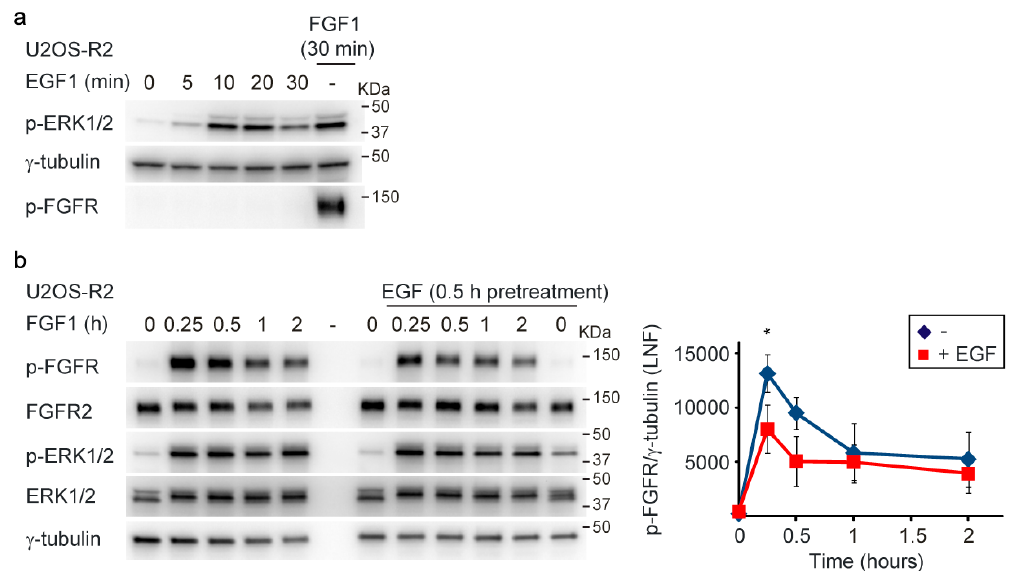
Figure 2. Pretreatment with EGF reduces the response to FGF1. ( a ) U2OS ‐ R2 cells were kept in serum ‐ free media for 2 hours and then 100 ng/mL EGF or 100 ng/mL FGF1 was added to the cells. The cells were lysed after the indicated periods of time. A p in front of the name of the antibody indicates that it recognizes the phosphorylated form of the protein. ( b ) U2OS ‐ R2 cells were kept in serum ‐ free media for 2 hours. Then, EGF (20–100 ng/mL) was added to the samples as indicated. After 30 min, the cells were stimulated with 20 ng/mL FGF1 and heparin (10 U/mL) and lysed after the indicated periods of time. Cycloheximide (10 μ g/mL) was added at the beginning of the starvation period and kept throughout the experiment. After lysis, the cellular material was analyzed by immunoblotting using the indicated antibodies. A p in front of the name of the antibody indicates that it recognizes the phosphorylated form of the protein. Quantifications of three independent experiments are presented in the graph. The time ‐ point of 30 minutes is only from two experiments. The bands corresponding to phosphorylated receptor were normalized to LNF ( γ‐ tubulin). Error bars denote the standard deviation. The difference between EGF ‐ pretreated cells versus cells not treated with EGF was significant at the time point of 15 minutes (* p ≤ 0.05, 1 ‐ way ANOVA, Tukey test, n = 3).